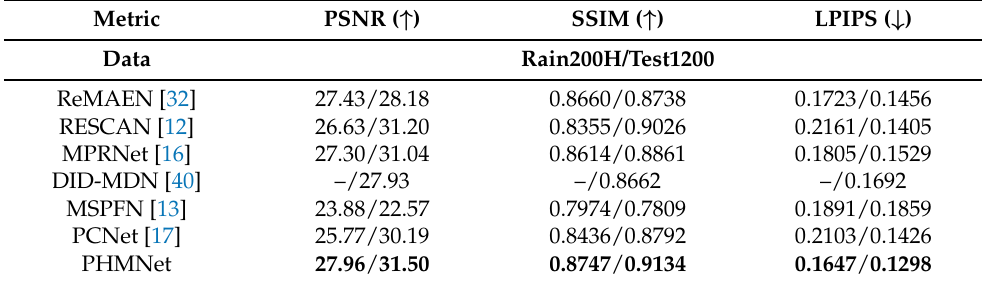
Table 1. Metric values (PSNR/SSIM/LPIPS) of the proposed PHMNet and the compared methods on the synthetic datasets. ( ↑ ) indicates higher scores, better image quality. ( ↓ ) indicates smaller scores, better image quality. Best results are marked in